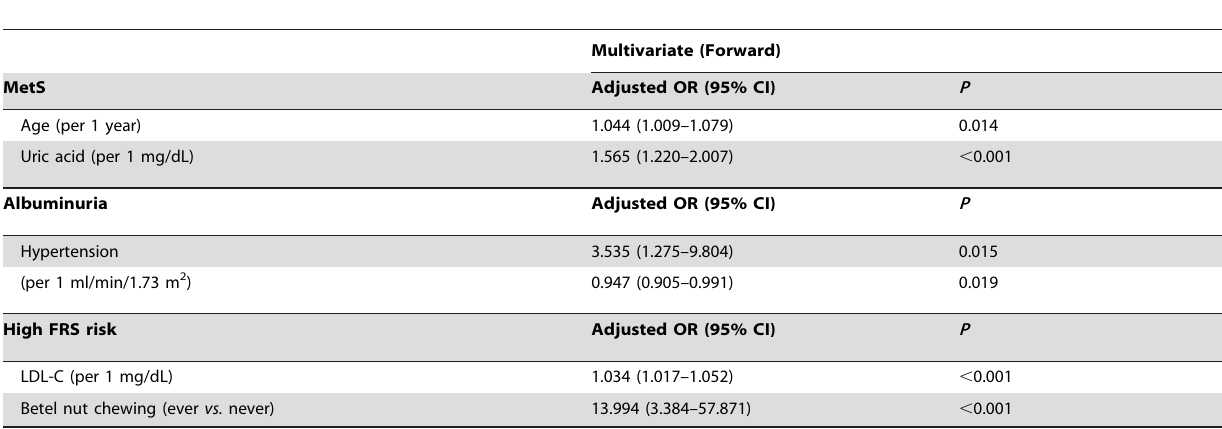
Table 5. Determinants of MetS, albuminuria, and high FRS risk in relatives of HD